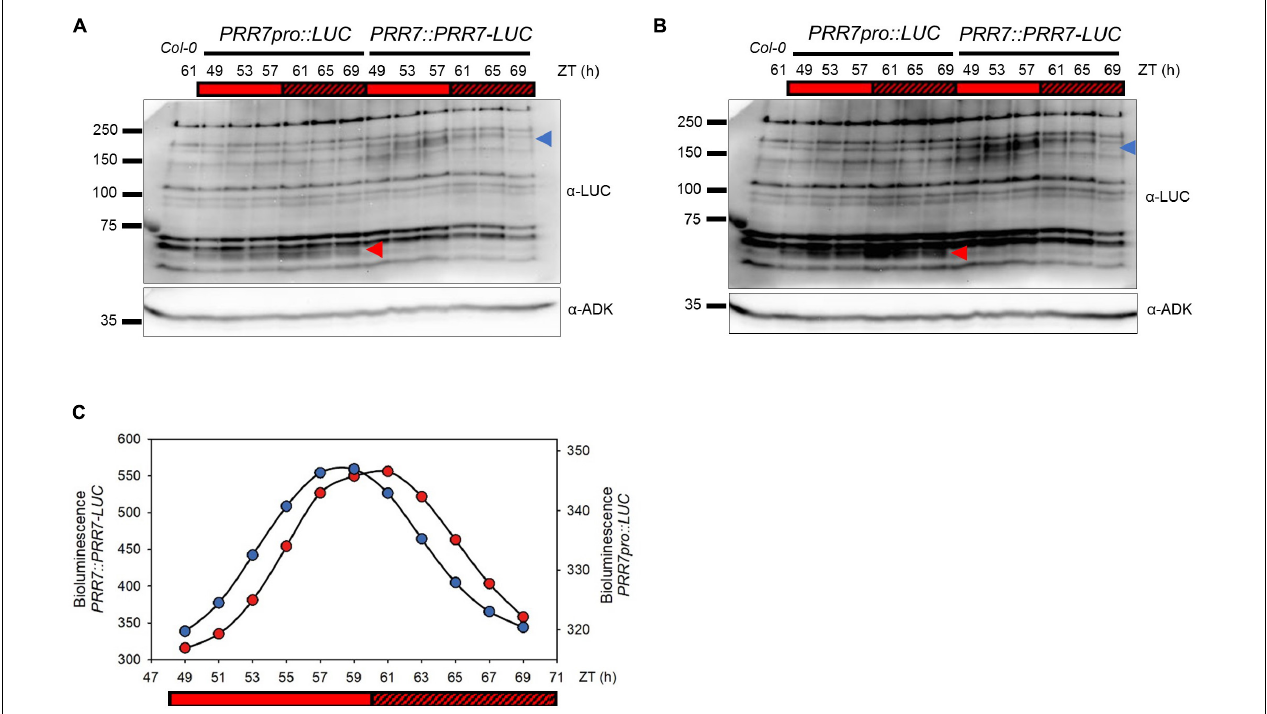
FIGURE 1 | Cycling pattern of PRR7-LUC protein abundance in PRR7::PRR7-LUC . (A) Image of immunoblotting of luciferase and PRR7-LUC in PRR7pro::LUC and PRR7::PRR7-LUC , respectively. 11-days old seedlings grown in 12L:12D white-light cycles were released to continuous red light (50 µ mol m − 2 s − 1 ) and collected at indicated ZT time points. Protein abundances of luciferase (red arrowhead) and PRR7-LUC (blue arrowhead) were analyzed by anti-LUC immunoblotting after TCA protein precipitation. ADK protein was used as a loading control. (B) Longer exposure image of immunoblotting. (C) Relative luminescence intensity of luciferase ( PRR7pro::LUC, red ) and PRR7-LUC ( PRR7::PRR7-LUC, blue ). 7-day old seedlings grown under same conditions as used in immunoblotting were subjected to luminescence imaging analysis. PRR7-LUC is indicated by the blue arrow (A) showing a cycling pattern consistent with luminescence